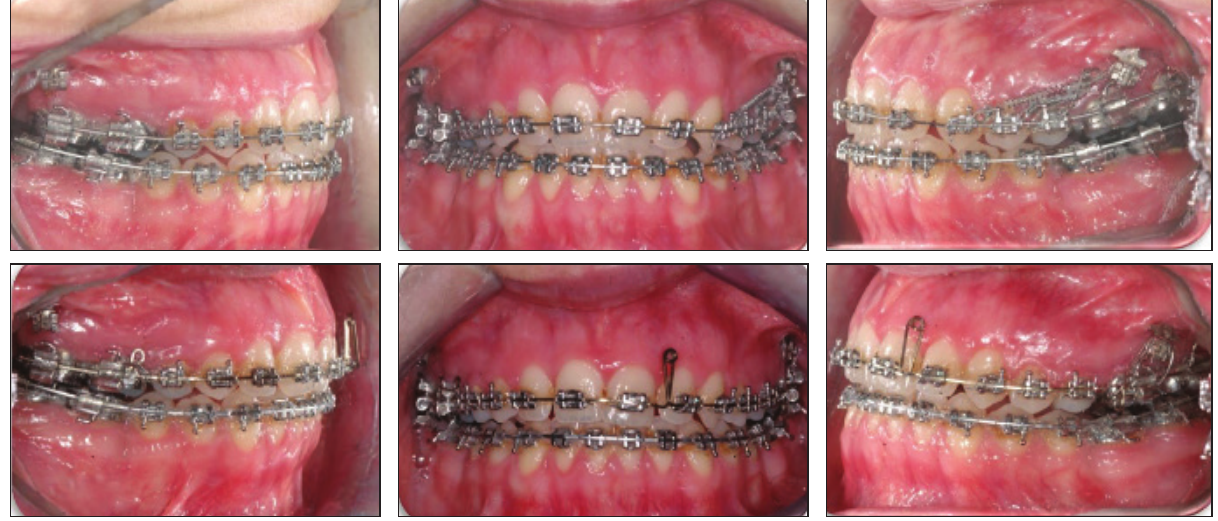
Figure 5. Intra-oral photographs of the patient with orthodontic